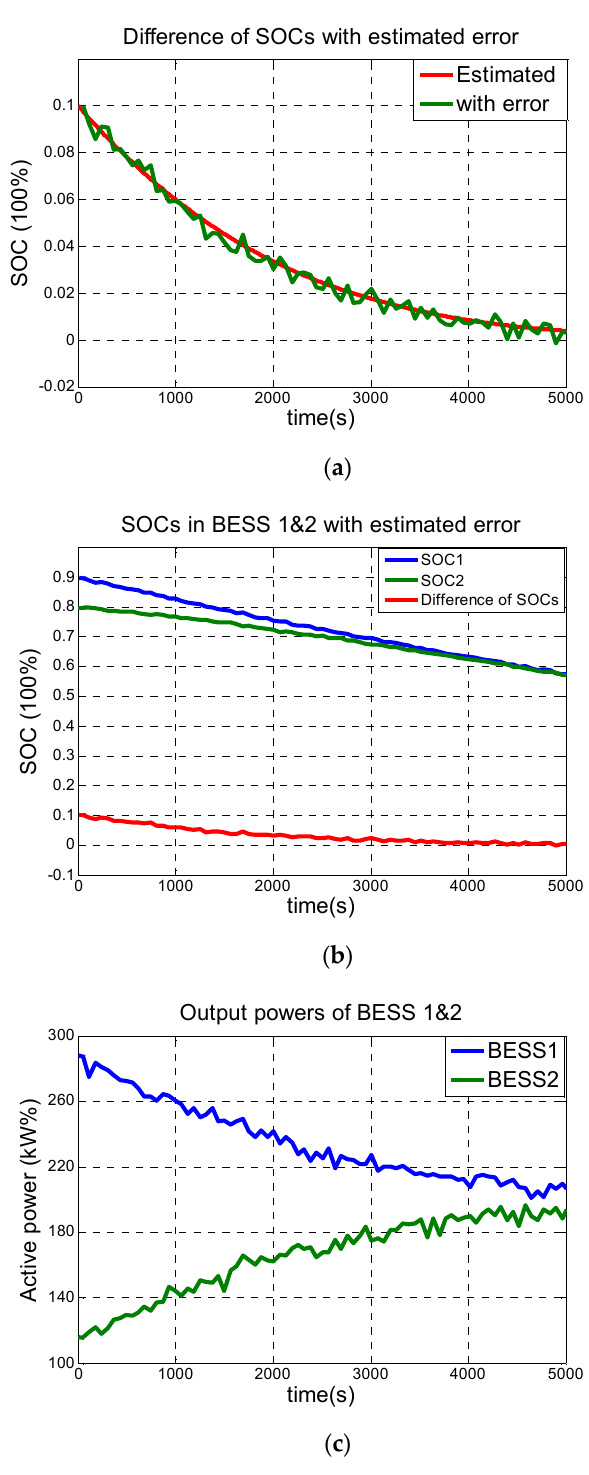
Figure 10. SOC and power sharing waveforms with consideration estimated errors. ( a ) Waveforms of SOC estimated and with errors; ( b ) waveforms of SOCs with errors and ( c ) waveforms of output powers with estimated errors.